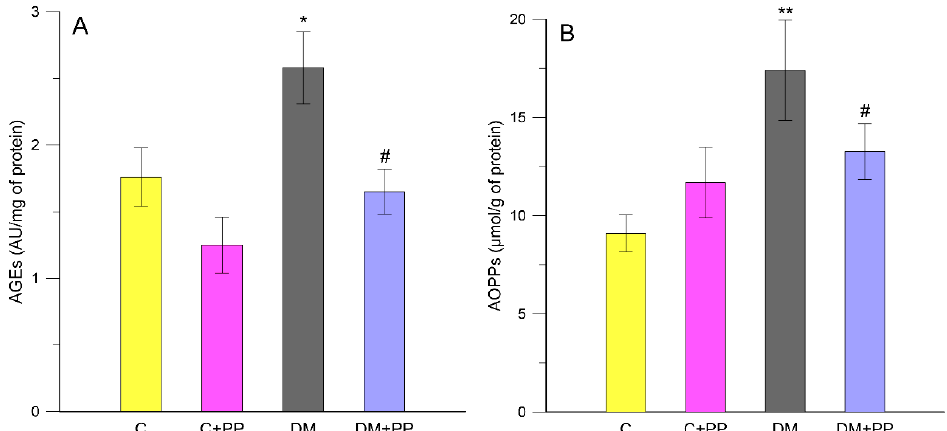
Figure 5. The effect of purple potato (PP) extract from Blue Congo (daily dose of 165 mg/kg b.w. for 14 days) on the content of advanced glycation end-products (AGEs) ( A ) and advanced oxidation protein products (AOPPs) ( B ) in rats ′ blood plasma. C—control group, C + PP—control rats receiving extract from Blue Congo, DM—diabetic group, DM + PP—diabetic rats treated with Blue Congo extract. The results are shown as means ± SD. Designations: * p < 0.05, ** p < 0.01 compared to the control group; # p < 0.05 compared to the DM group.